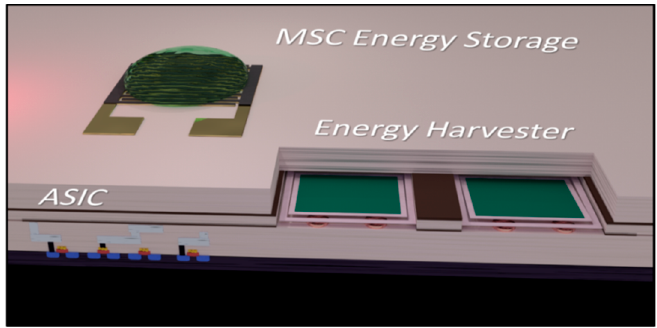
Figure 10. Schematic of a potential future self-powering system consisting back end of the line (BEOL) integration of an microsupercapacitors (MSC) and harvester with application specific integrated circuit (ASIC) components.